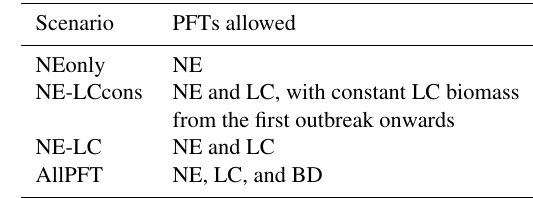
Table 2. The four different scenarios simulated for the coexistence of plant functional types (PFTs). NE is needleleaf evergreen tree (i.e., the target PFT); LC is lower canopy (i.e., the sum of evergreen shrubs, cold-deciduous shrubs, and C 3 grasses); BD is broadleaf deciduous